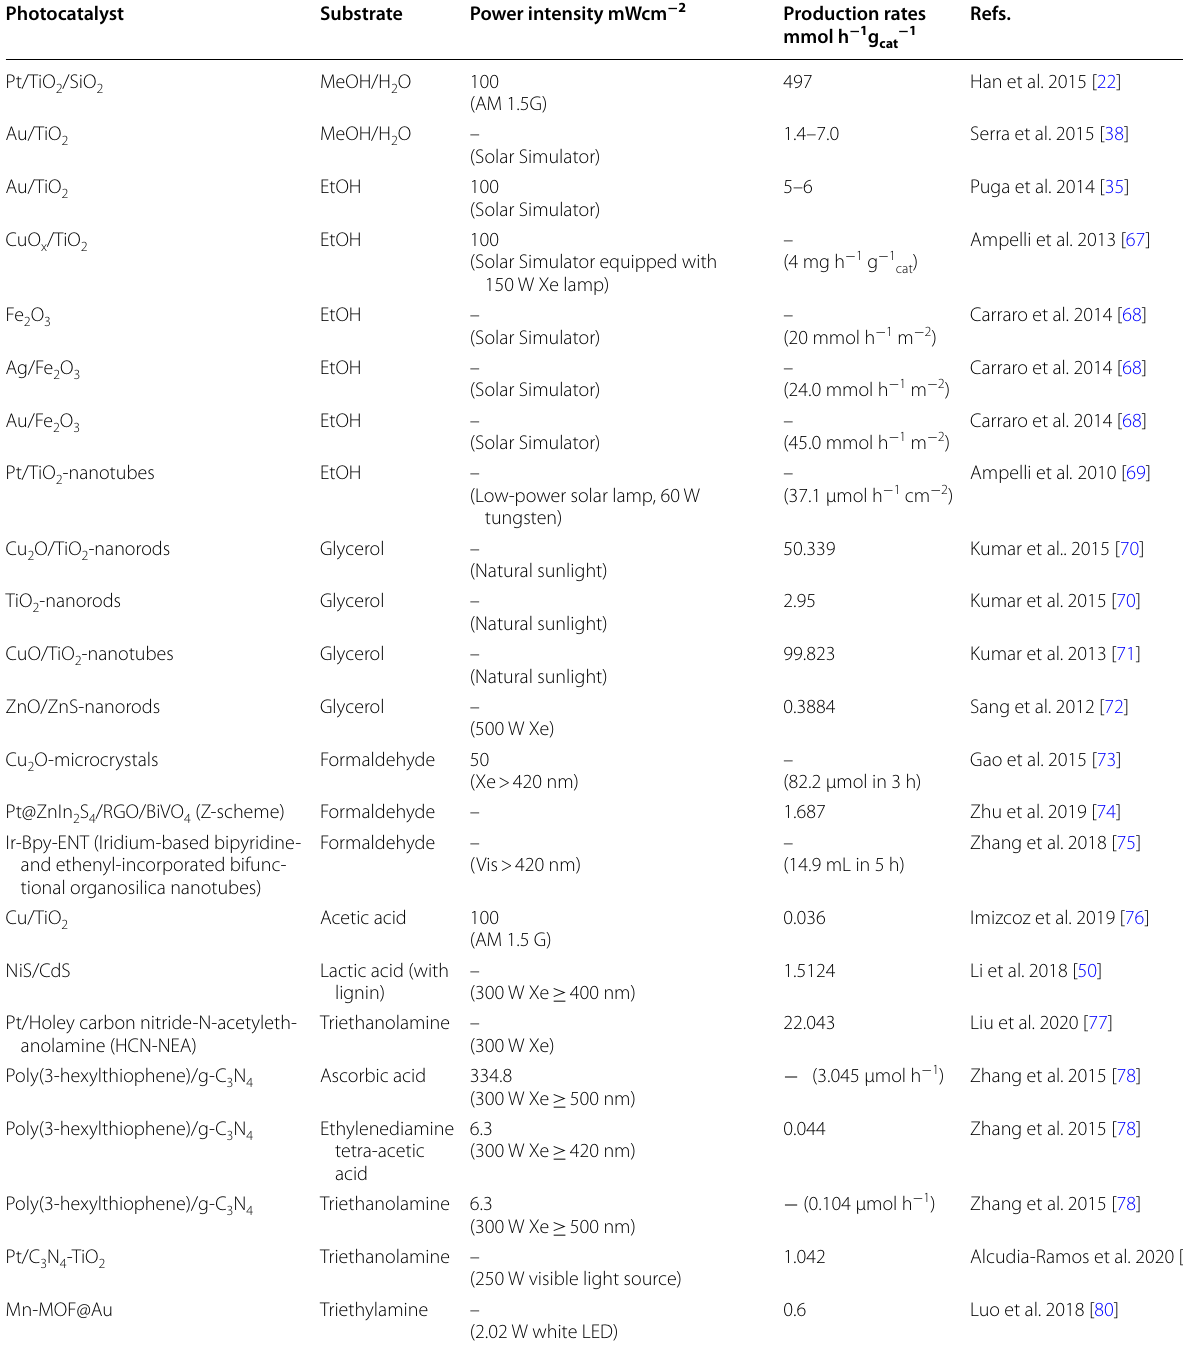
Table 1 Photocatalytic hydrogen production from monomeric substrates using visible light sources